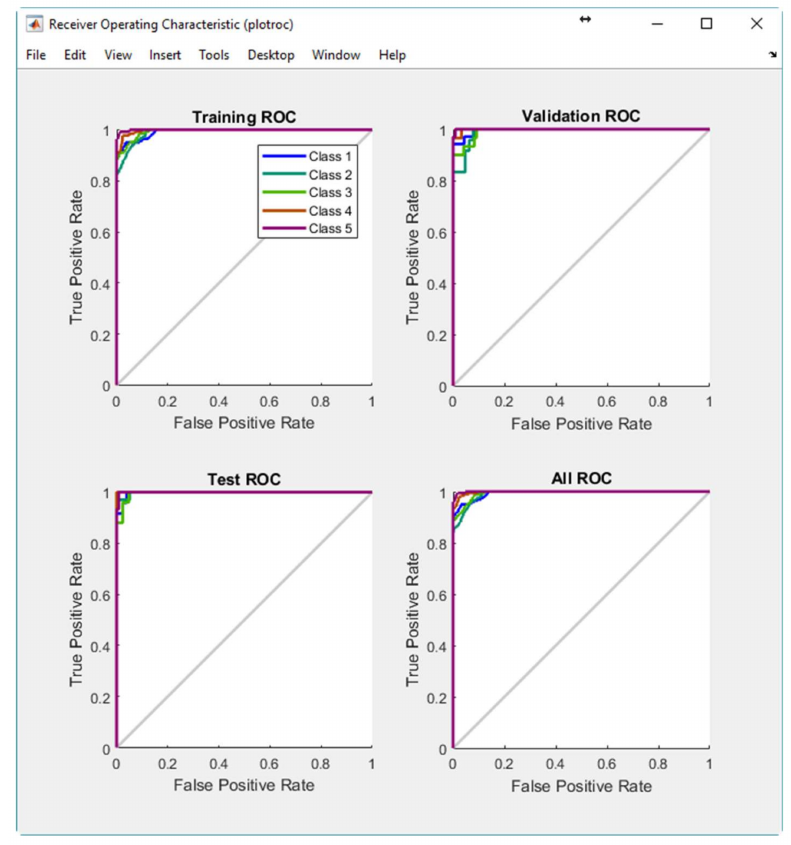
Figure 11. Receiver Operating Characteristic